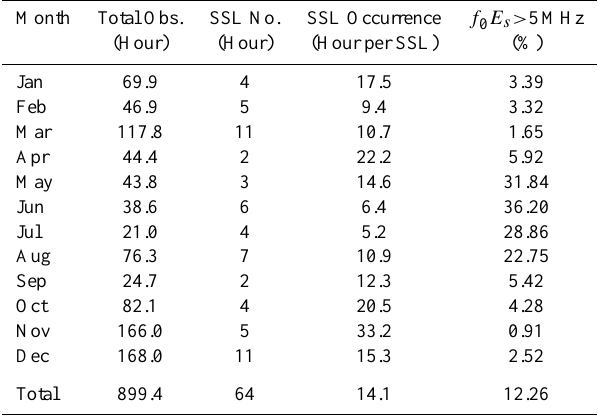
Table 3. Seasonal variations of probability of occurrence of SSL and E S